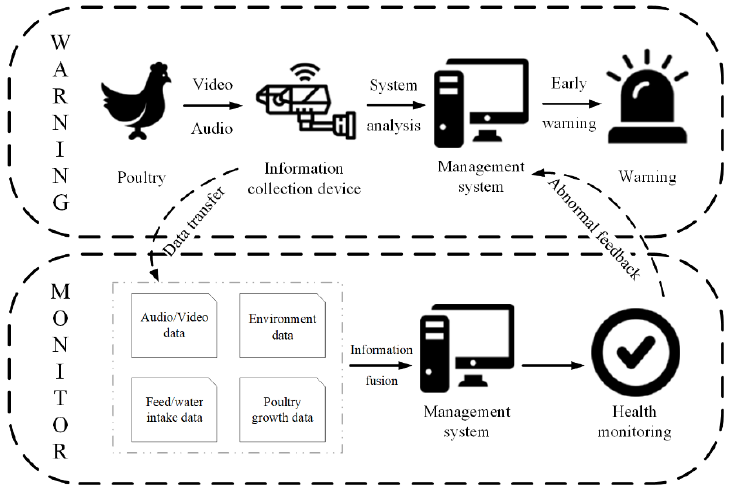
Figure 11. The principle diagram of the method of monitoring the health status of poultry and early warning of disease.